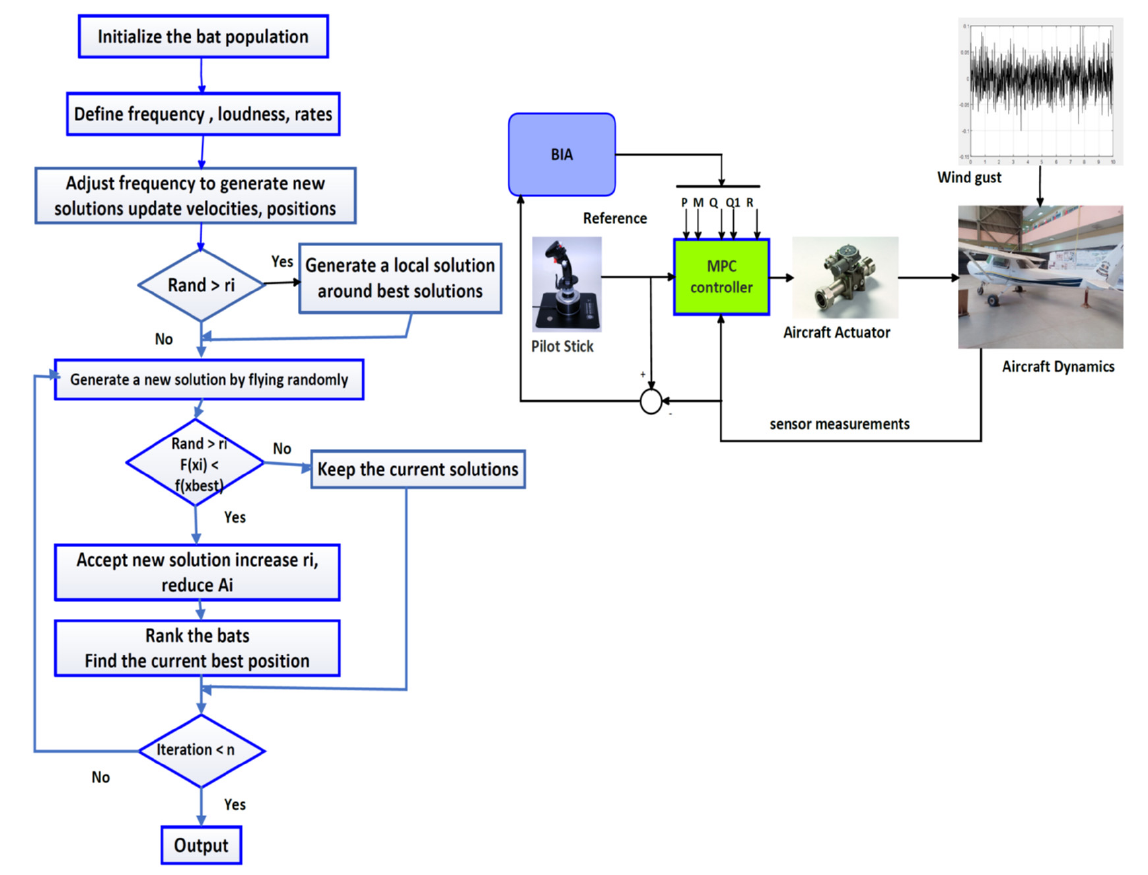
Figure 7. The BIA flowchart with aircraft model predictive controller tuning process.